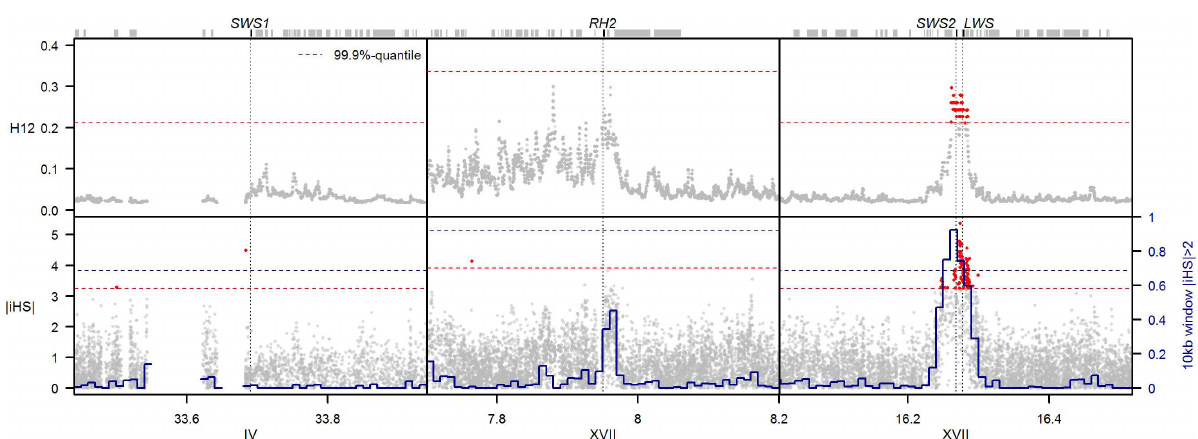
Fig 1. Scan for selective sweeps around cone opsins in Haida Gwaii threespine stickleback. One of the strongest outlier regions for H12 and iHS in the genomeof Haida Gwaii sticklebackfrom 28 populations is centeredon SWS2 and LWS , indicating a past selective sweep in this region. No such signatureis found aroundthe other two cone opsins. Grey dots show H12 (upper panel)and absoluteiHS (lower panel)values for each SNP with a minor allelefrequency (MAF) greater 5%, with top 0.1% outlier SNPs highlightedas red dots. The proportionof iHS-SNPs with a value greater than 2 per 10 kb windowis shown as a blue line. The 99.9%-quantile boundaries are shown as red- and blue-dashedlines for SNPs and windows, respectively. Genomic coordinatesin Mb based on an improvedversionof the stickleback reference genome[51] are given on the x-axis. The positionof the four cone opsin genes is highlightedwith black boxes and vertical dashedlines; grey boxes indicateother genes. Depictedvalues for H12, iHS, window-iHS, and 99.9%-quantile boundariescan be found in S1